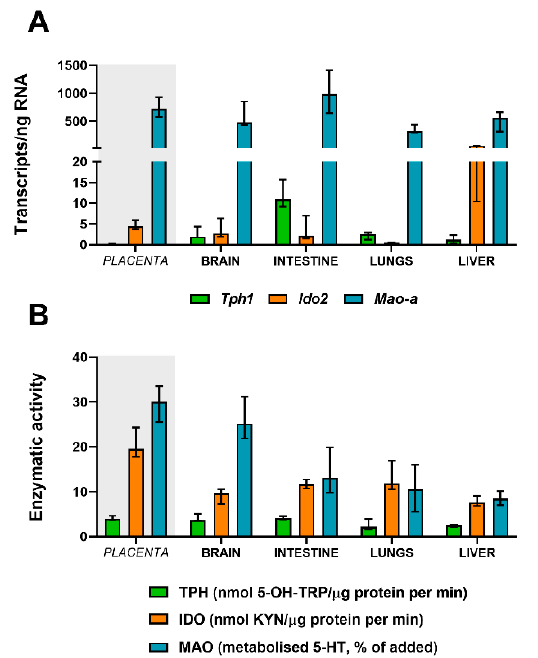
Figure 6. Gene expression and activity of Tph1 / TPH, Ido2 / IDO, and Mao-a / MAO in fetal organs. ( A ) Gene expression evaluated by digital droplet PCR analysis of the rate-limiting enzymes for the 5-HT pathway ( Tph1 and Mao-a ) and KYN pathway ( Ido2 ) at GD 21. ( B ) Functional analysis of TPH, IDO, and MAO enzymatic activity in fetal organs at term. Data are presented as the median with IQR; n = 5 for each gestational age.